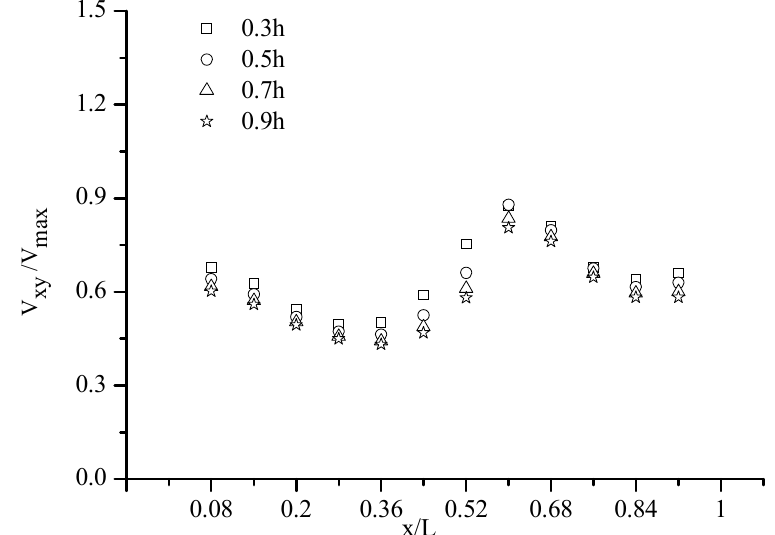
Figure 2. Dimensionless velocity distribution curves in y = 0.225 m along the x direction in four different horizontal planes with Q = 13.5 L/s (V max represents maximum V in the slot, V xy represents the velocity in xy-plane, x is the distance along x-direction in one pool, L is the length of a pool).